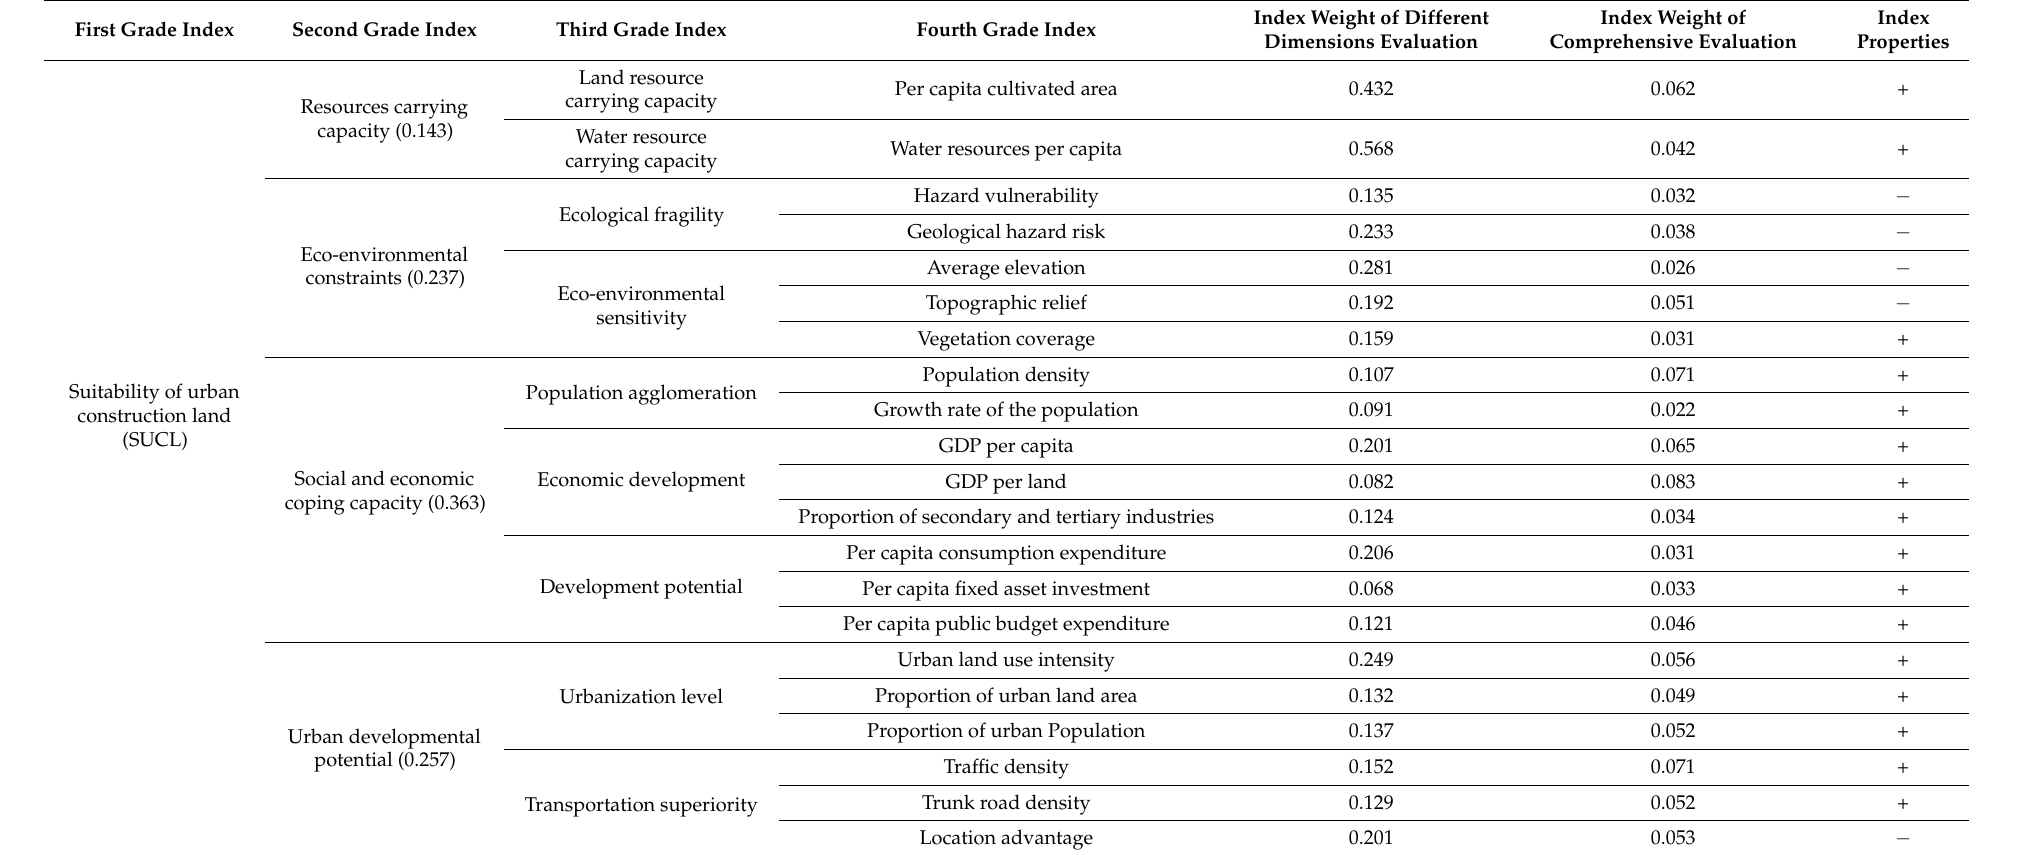
Table 1. Index system and index weights of the suitability evaluation of urban construction land